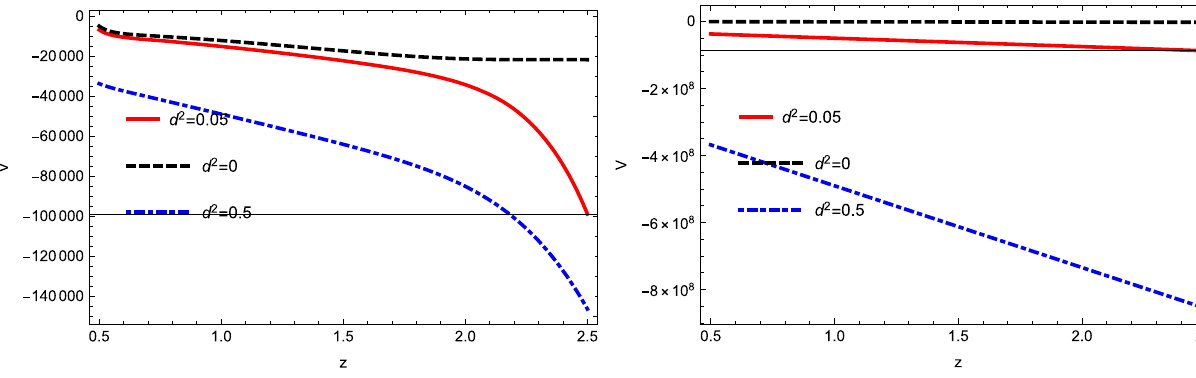
Fig. 9 Plot of V verses z for u = 1 and u = 2 . 002 for tachyon scalar field model